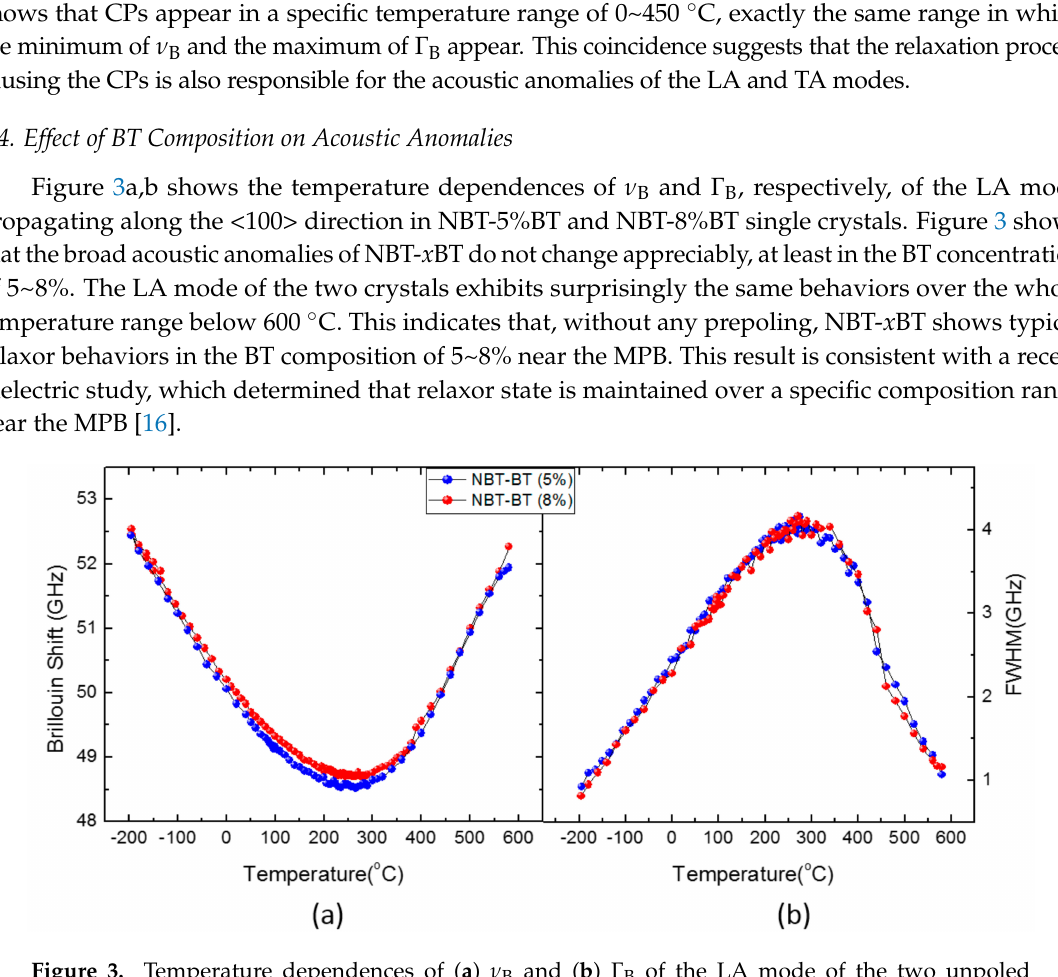
Figure 3. Temperature dependences of ( a ) ν B and ( b ) Γ B of the LA mode of the two unpoled (Na 1/2 Bi 1/2 )TiO 3 - x BaTiO 3 (NBT- x BT) with x = 5% and 8% single crystals. The phonon propagation direction is along the <100>